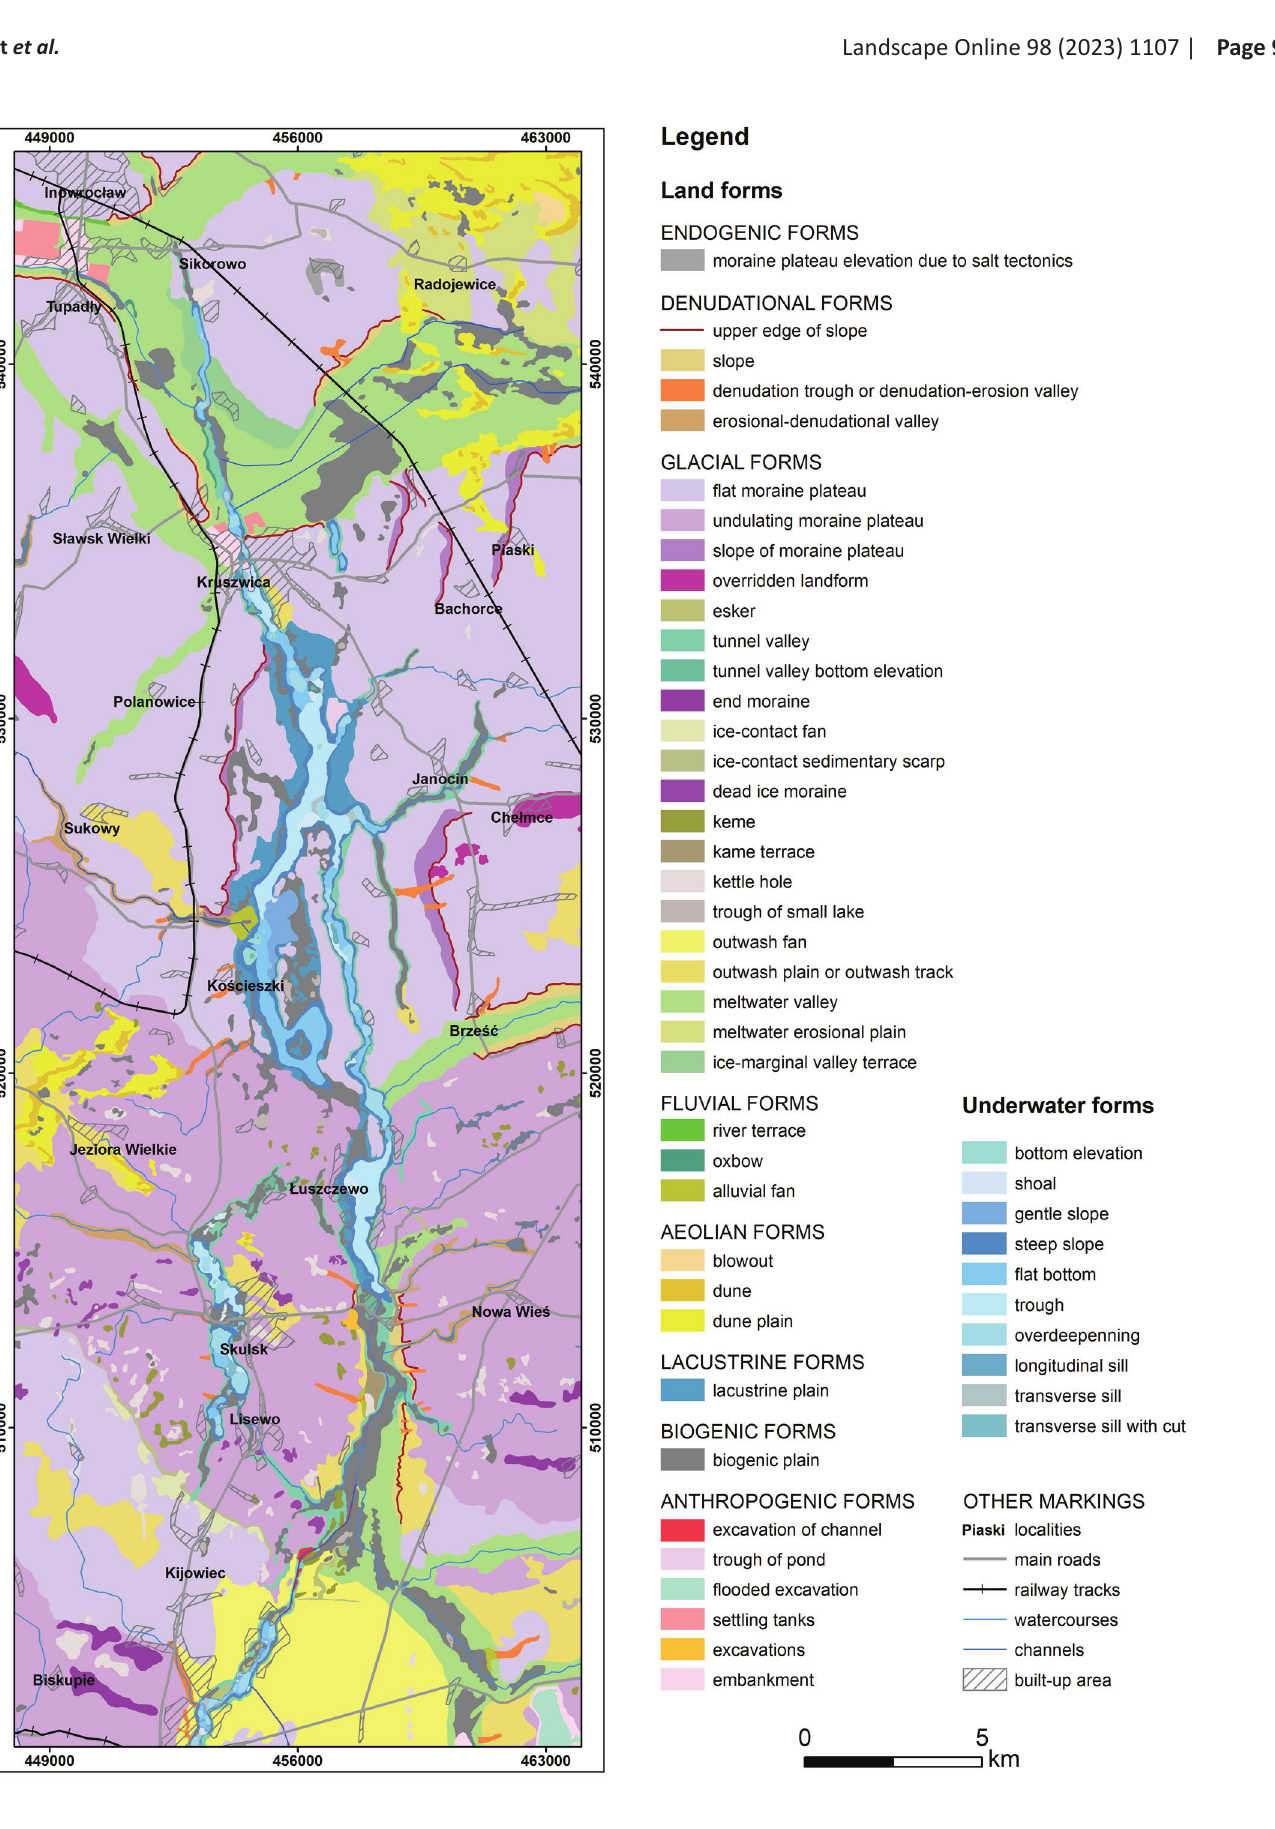
Figure 6. Geomorphological map of the research